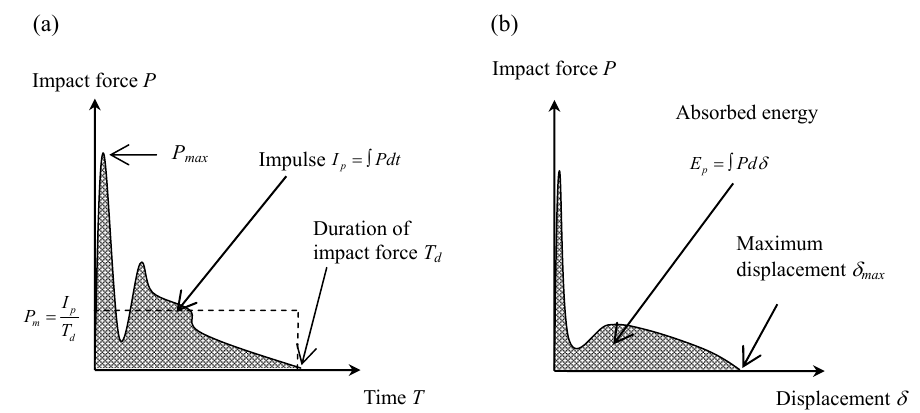
Fig. 5. Characteristic values. (a) Time response of impact force. (b) Force-displacement curve.